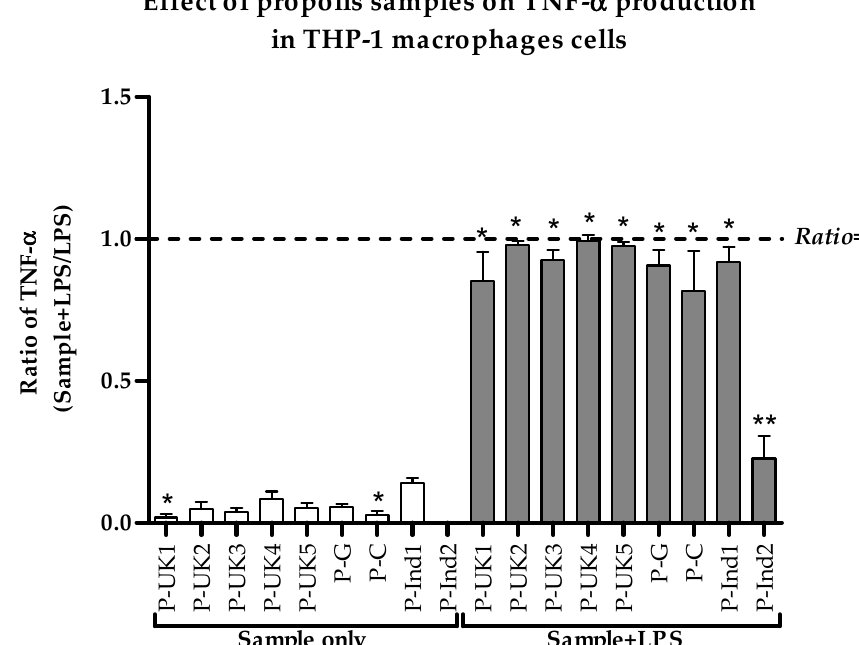
Figure 2. E ff ect of propolis extracts on the production of TNF- α by phorbol 12-myristate 13-acetate (PMA)-di ff erentiated THP-1 cells in the absence and presence of lipopolysaccharide (LPS) (0.5 µ g / mL). The TNF- α levels were significantly di ff erent from the negative control levels in all eight combination treatments, except for the P-Ind2 extract ( n = 3). *: Significant ( p < 0.05) when compared with untreated control; **: Significant ( p < 0.05) when compared with LPS alone; P-UK (1–5): Five propolis extracts from the UK; P-G: Propolis from Ghana; P-C: Propolis from Cameroon; P-Ind (1 and 2): Two Propolis extracts from Indonesia.